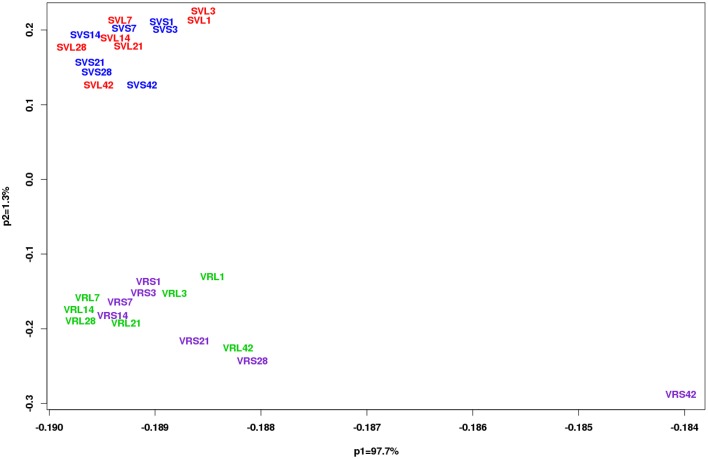
Principal component analysis (PCA) of genotype (V. riparia and Seyval) and time (D01, D03, D07, D14, D21, D28, and D42 of treatment). Analysis was conducted on the quality-controlled data (13,587 probesets in 6 replicates) using a correlation matrix. Photoperiod treatments are color coded for each genotype. V. riparia [LD, green (VRL1, 3, 7, 14, 21, 28, and 42); SD, purple (VRS1, 3, 7, 14, 21, 28, and 42)] and Seyval [LD, red (SVL1, 3, 7, 14, 21, 28, and 42) and SD, blue (SVS1, 3, 7, 14, 21, 28, and 42)].